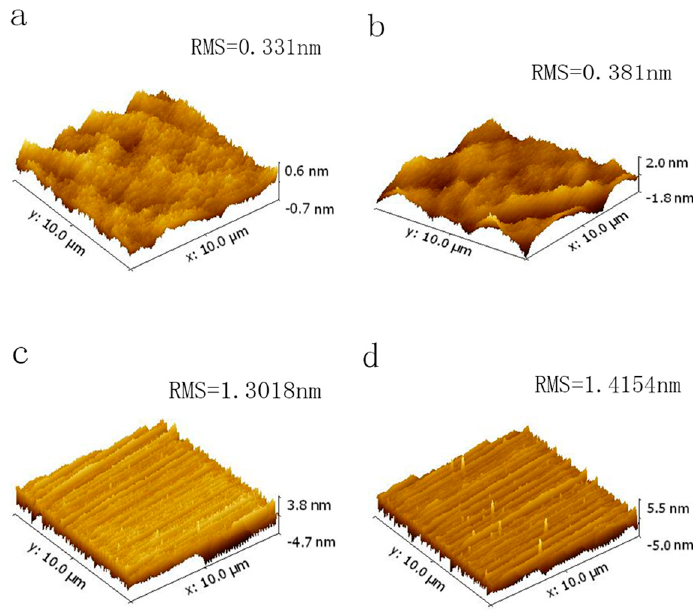
Figure 4. Atomic force microscopy (AFM) images (10 μ m × 10 μ m) of approximately 20- μ m-thick 4H-SiC epitaxial layers grown under different pressures: ( a ) 100 mbar; ( b ) 80 mbar; ( c ) 60 mbar;